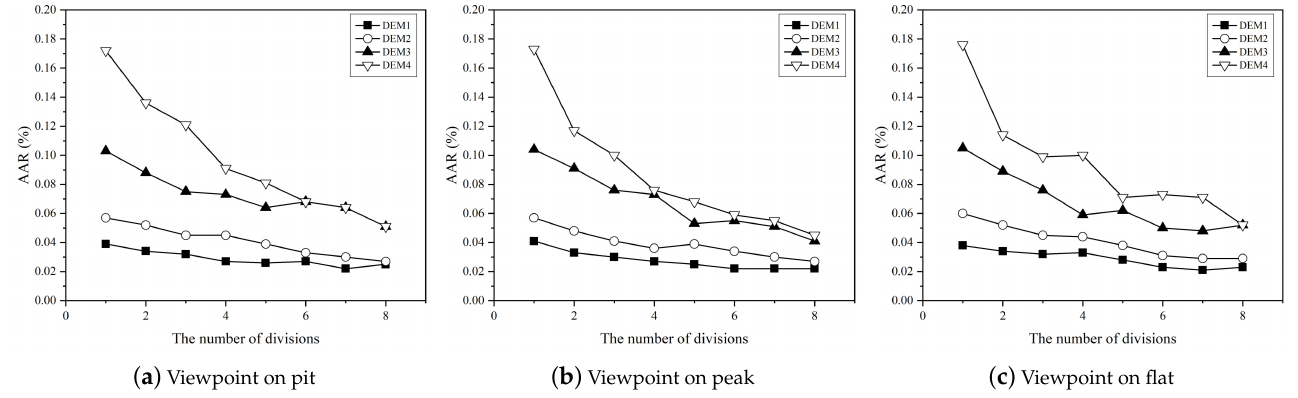
Figure 14. Comparisons of the average area ratio of different number of